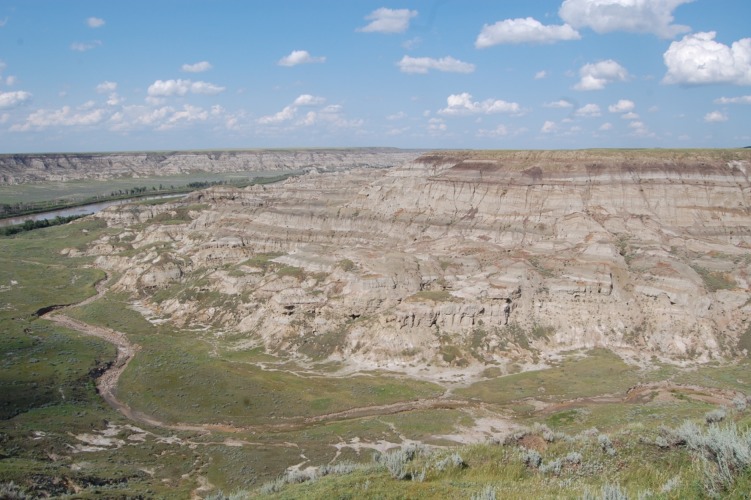
Ridge on which BB180 is located. View looking east at mouth of Jackson Coulee, Dinosaur Provincial Park, AB.